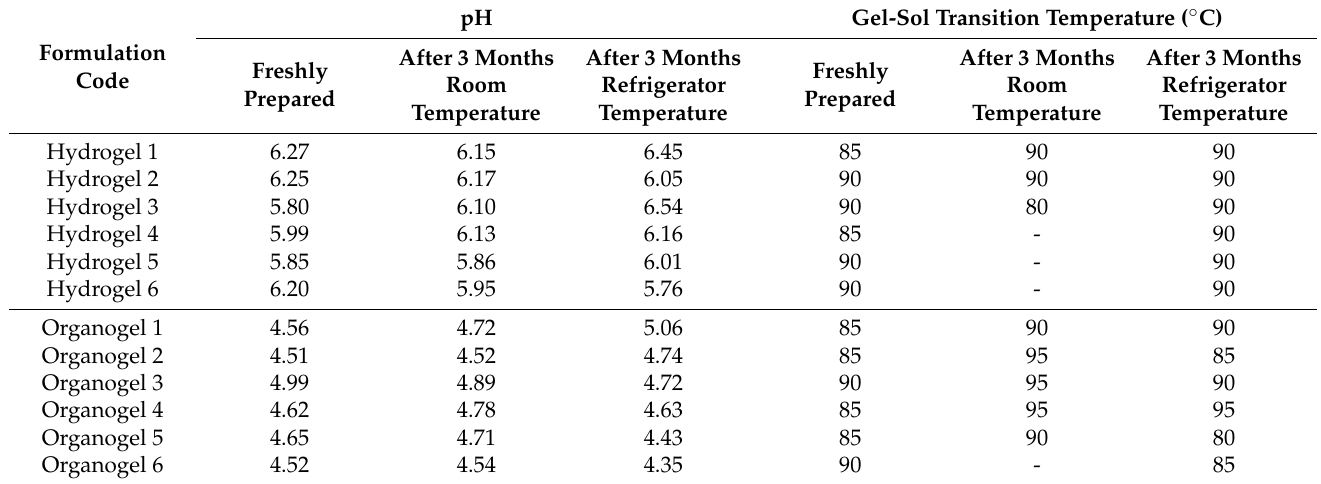
Table 5. The pH and gel-sol transition temperature results in hydrogels and